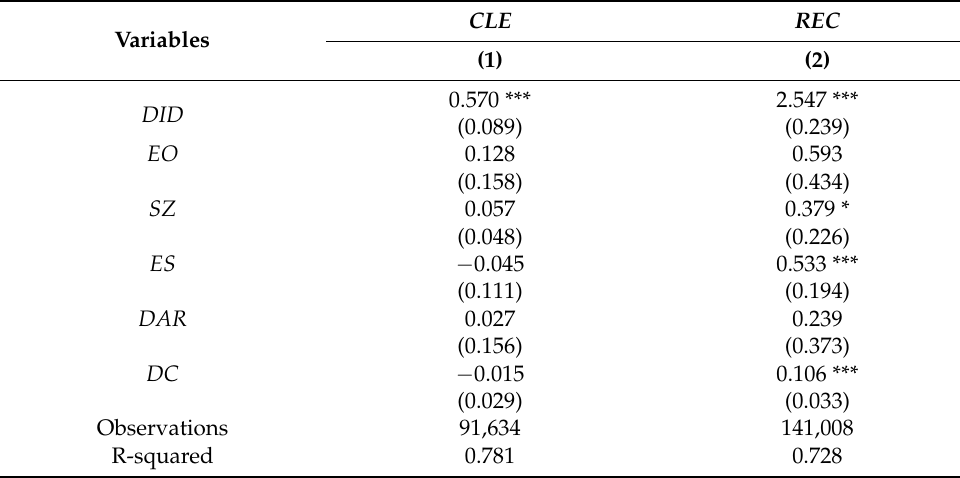
Table 5. Regression results of the resource structure adjustment